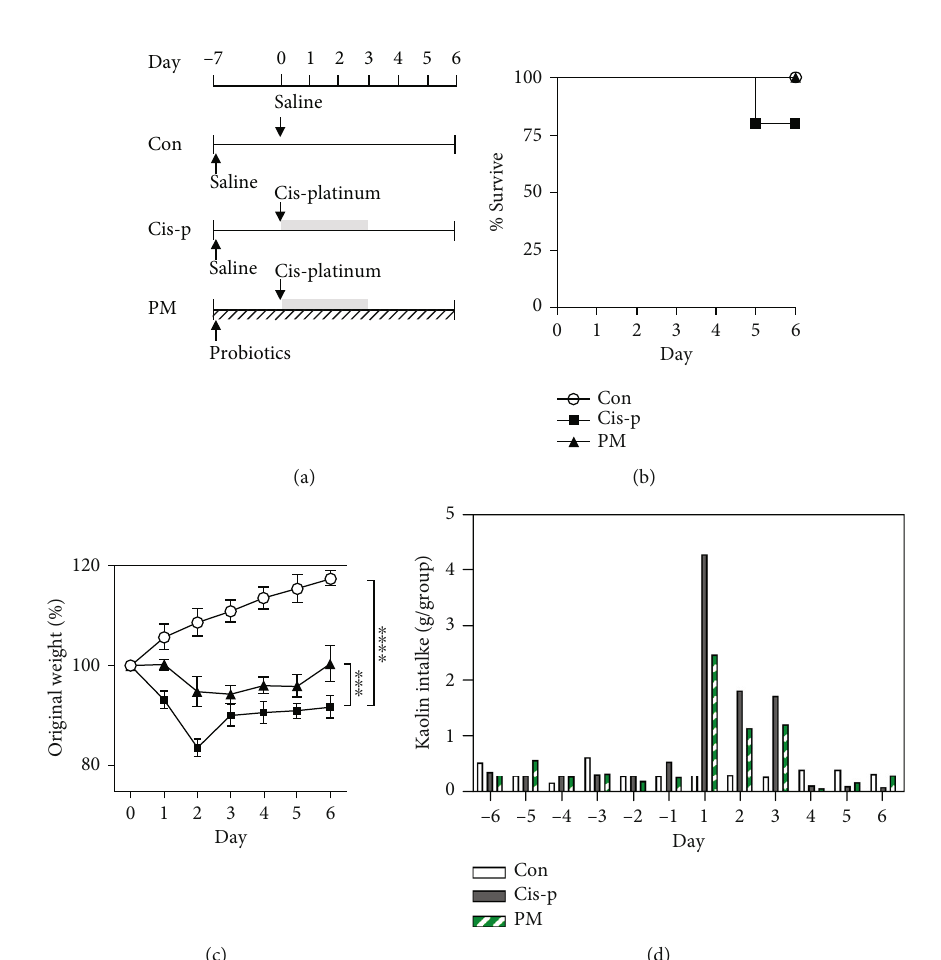
Figure 1: E ff ects of probiotic mixture on cisplatin-induced mucositis and pica in rats ( n = 5 ): (a) experimental setup, (b) survival rate, (c) body weight, and (d) kaolin consumption. Con: normal control group; Cis-p: cisplatin-treated model group; PM: probiotic mixture- and cisplatin-treated